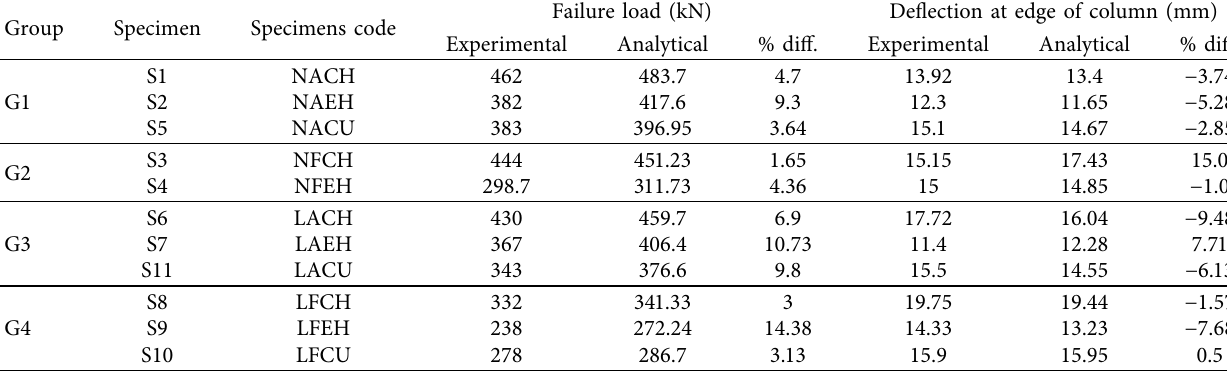
Table 2: Verification of the analytical model and tested specimens of Riad and Shoeib [18]. Group